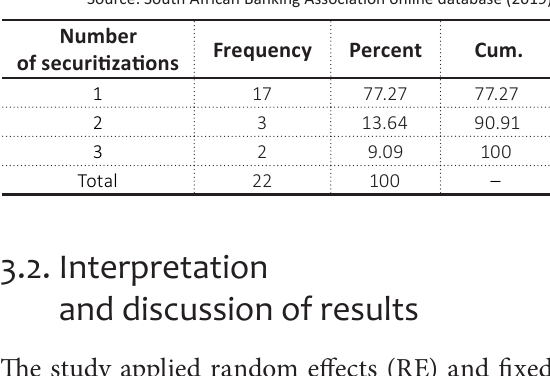
Table 3. Frequency of securitization per bank per year